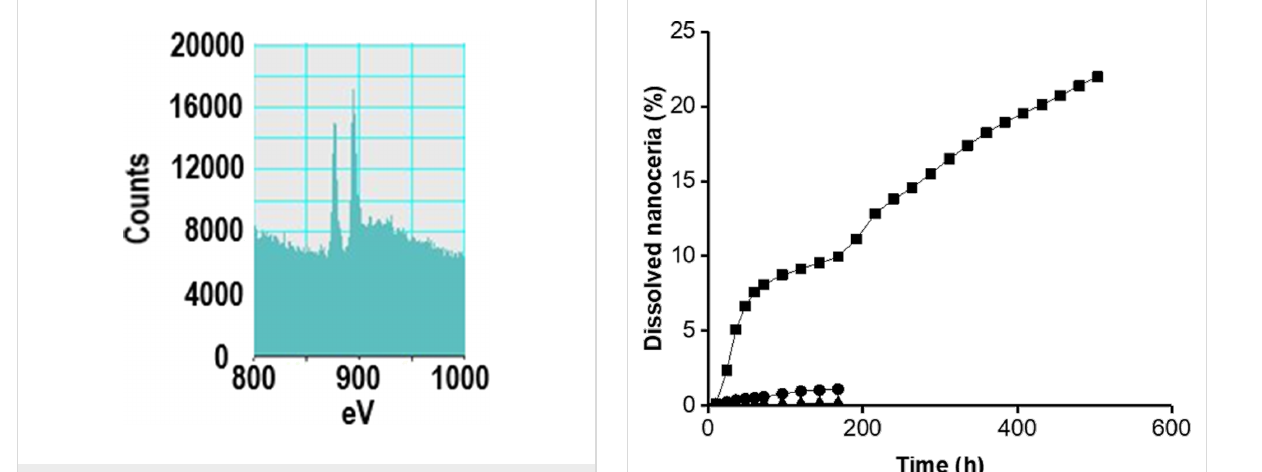
Figure 6: Electron energy loss spectroscopy of calcined solvother- mally synthesized nanoceria. much slower (Figure 8 and Table 2). High-temperature expo- sure greatly decreased the dissolution of the solvothermally syn- thesized nanoceria (Figure 9).